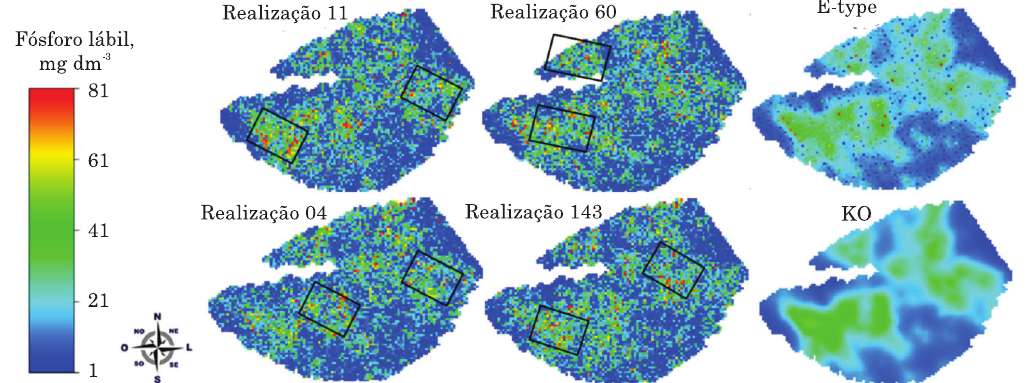
Figura 4. Mapas estimados do fósforo lábil: realizações sorteadas da SSG (11, 60, 94 e 143), média das realizações ( E-type ) e KO.